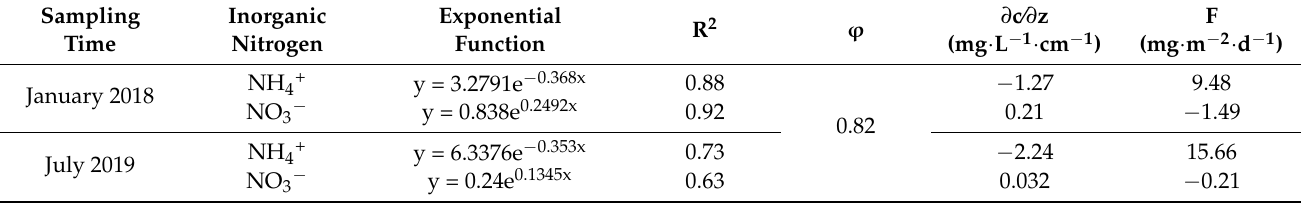
Table 4. Calculation of inorganic nitrogen diffusion fluxes at the SWI of WJD.